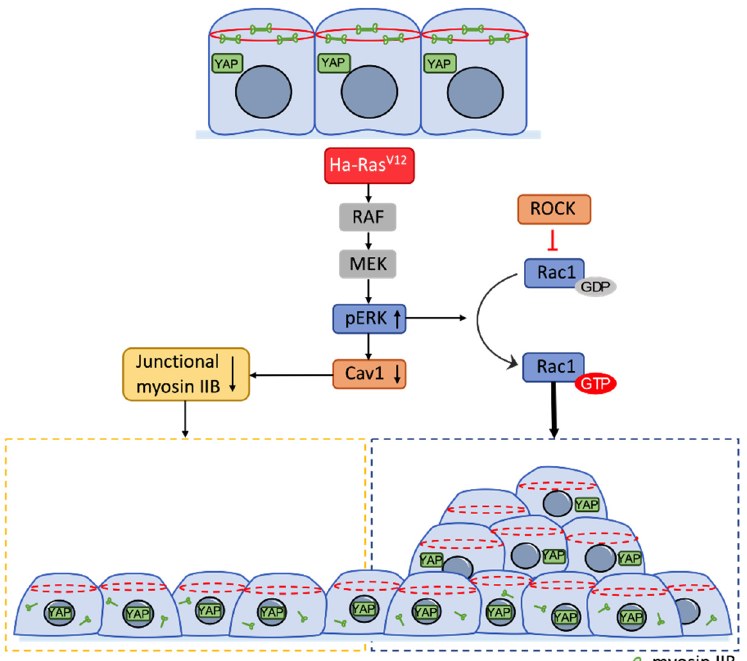
Figure 8. Mechanism of Ha-Ras V12 -induced YAP nuclear translocation and multilayer cellular aggregates. Ha-Ras V12 downregulated Cav1 through the ERK pathway, and further suppressed junctional myosin IIB so as to promote YAP nuclear retention. Ha-Ras V12 also induced the ERK-Rac pathway to trigger multilayer cellular aggregate formation at the overconfluent stage. ↑ indicates upregulation and ↓ indicates downregulation.